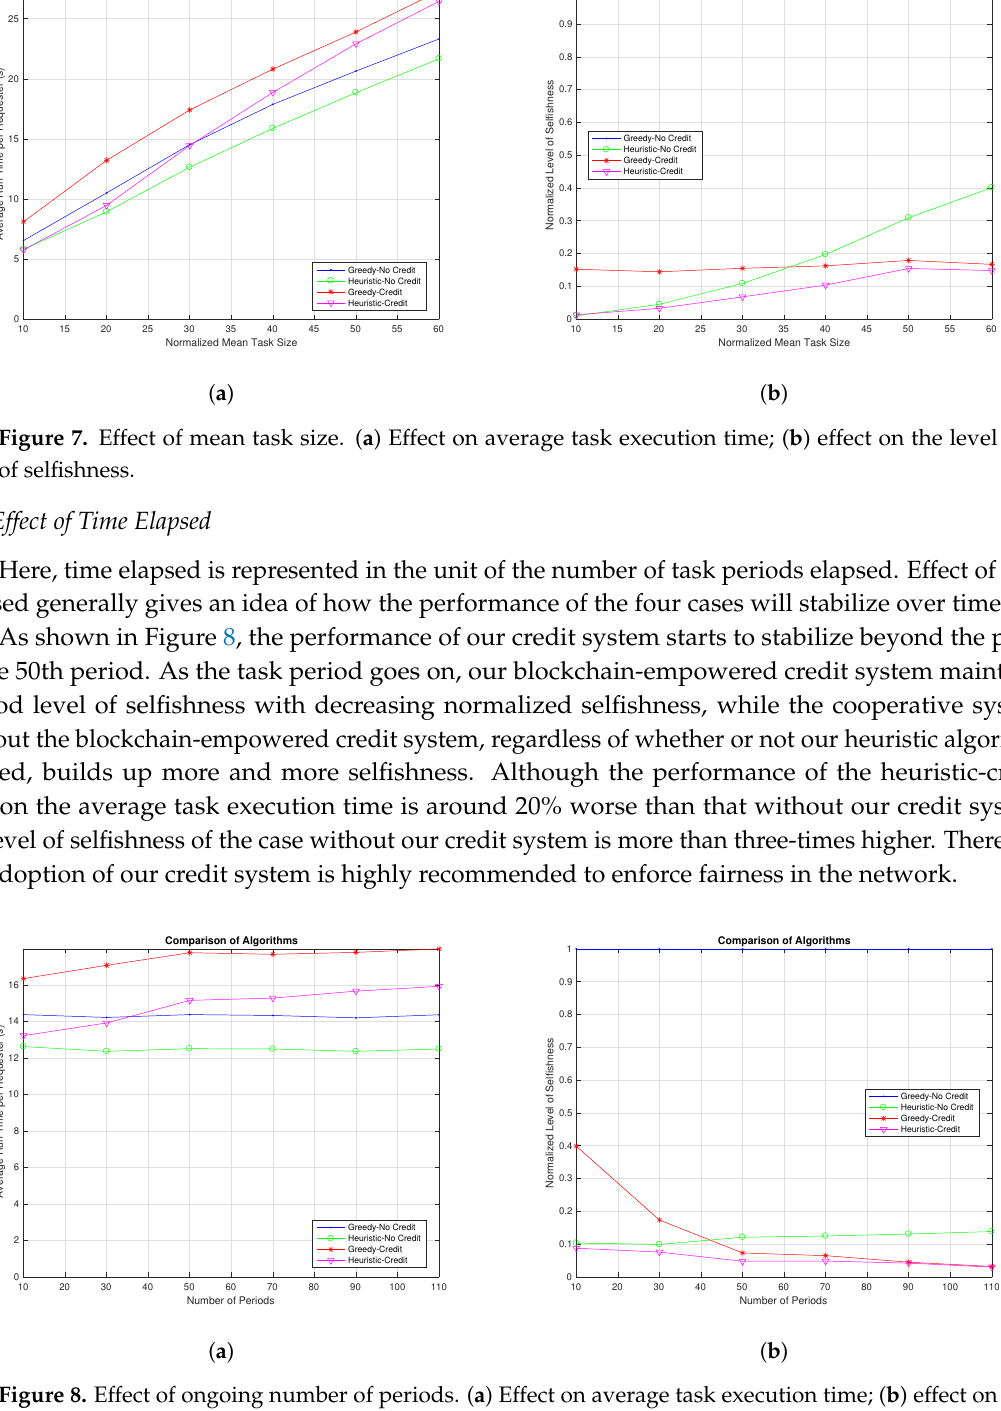
Figure 8. Effect of ongoing number of periods. ( a ) Effect on average task execution time; ( b ) effect on the level of